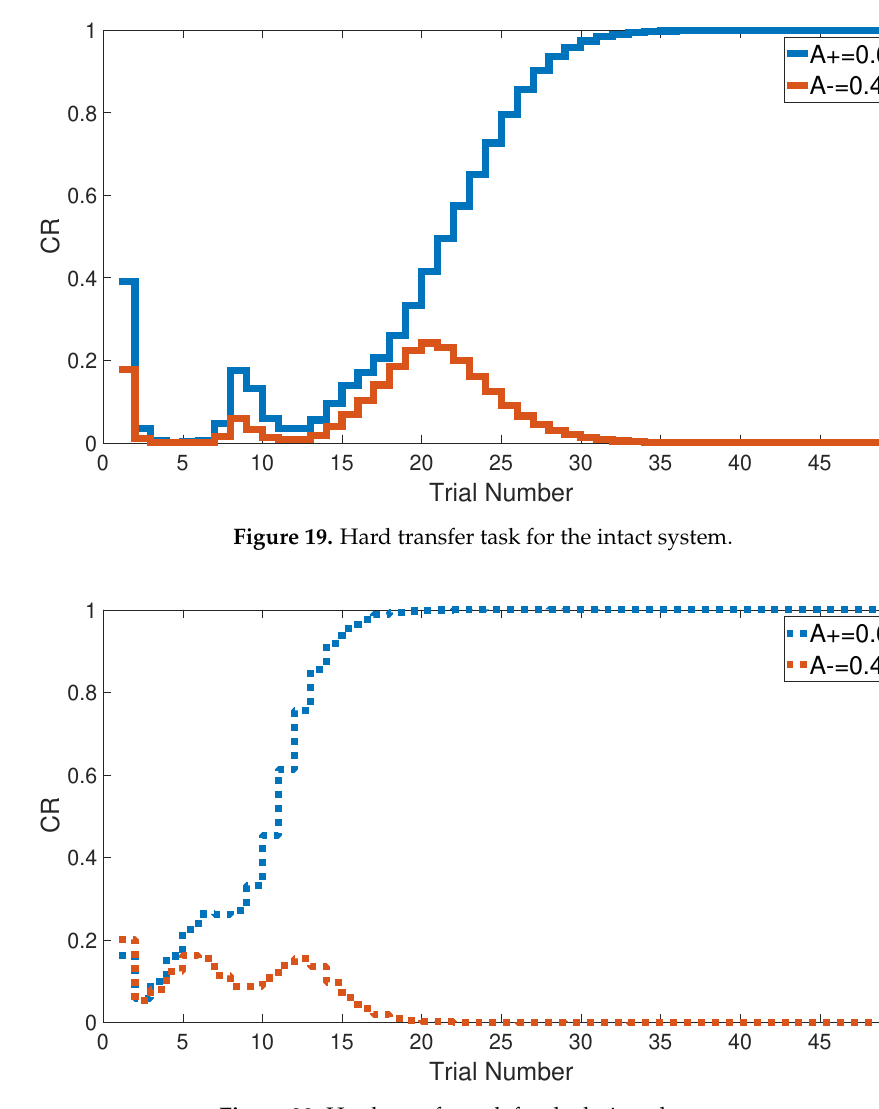
Figure 20. Hard transfer task for the lesioned system.